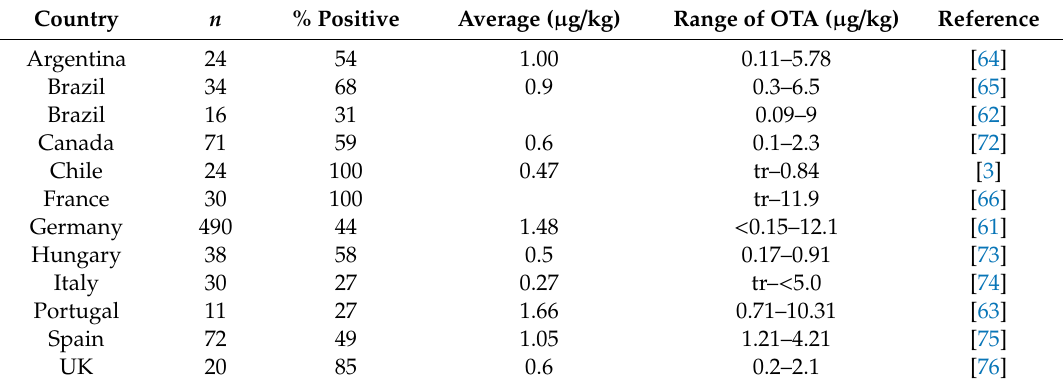
Table 2. Occurrence of OTA in roasted and / or ground roasted co ff ee by